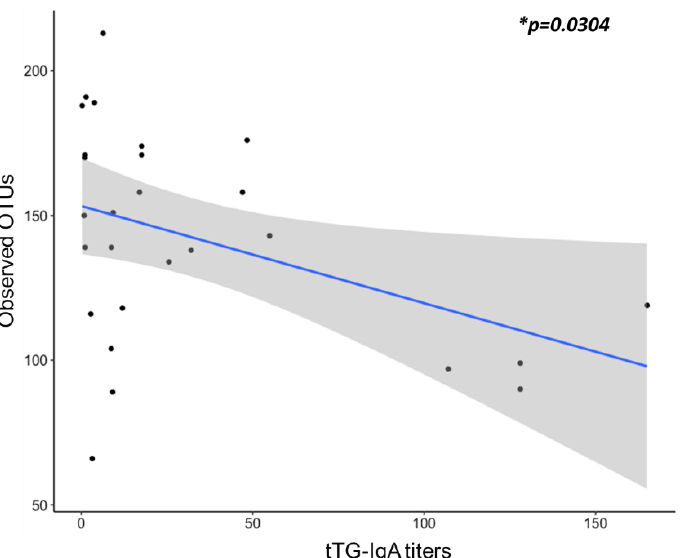
Figure 3. Linear regression was used to determine the correlation between the tTG titers ( x -axis) and alpha diversity indices observed OTUs ( y -axis). Abbreviations: OUT = Operational taxonomic units; Ttg-IgA = tissue transglutaminase IgA antibodies.